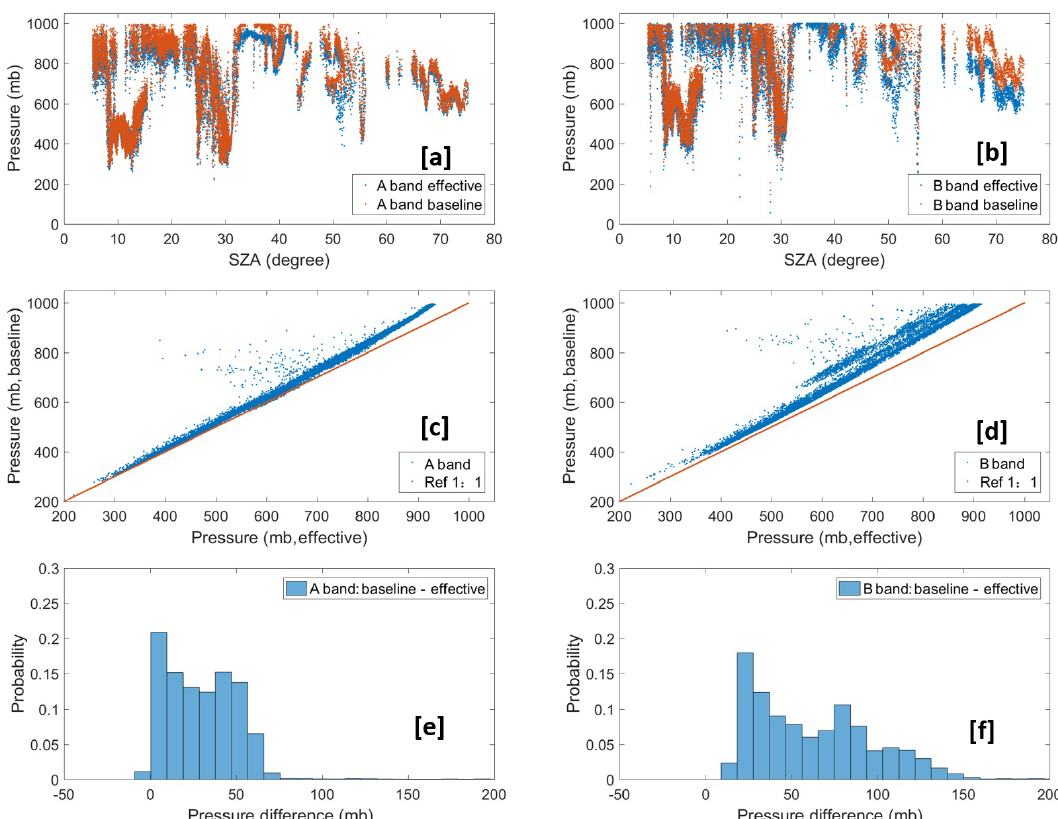
Figure 5. The comparison of effective CTPs (reference from NASA ASDC data) and baseline CTPs from our retrieval algorithm for the EPIC A and B